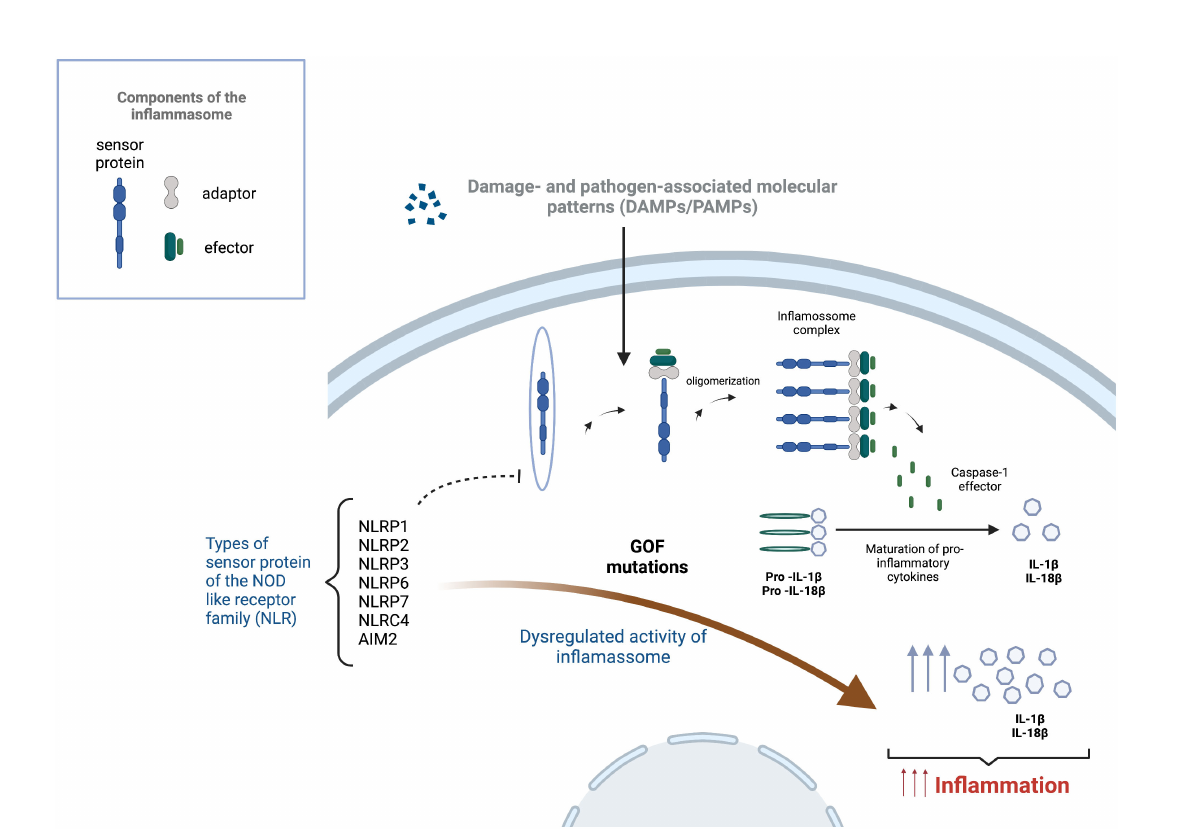
FIGURE 3 In fl ammasome activation and effect of gain of function mutations in the development of in fl ammasomopathies. In fl ammasome activation starts after a trigger, such as damage-associated molecular patterns (DAMPs) or pathogen-associated molecular patterns (PAMPs), is sensed by a sensor protein of the Nucleotide-binding and oligomerization domain (NOD) like receptor family (NLRP1, NLRP2, NLRP3, NLRP6, NLRP7, NLRC4 and AIM2), leading to the oligomerization and formation of multiprotein complex with the ability to cause the cleavage of caspase-1. This enzyme is responsible for the maturation of pro-in fl ammatory cytokines into their active form. Gain of function mutations (GOF) on the sensor proteins can lead to the dysregulation of the in fl ammasome causing increased levels of pro-in fl ammatory cytokines (IL-1 b and IL-18), leading to uncontrolled and damaging auto-in fl ammatory